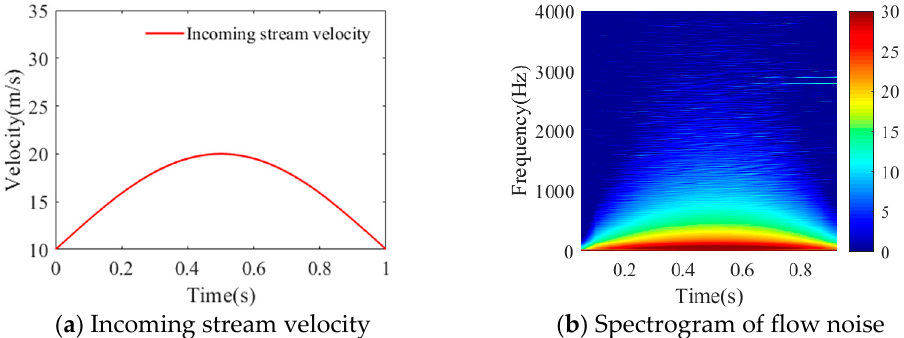
Figure 11. Inconstant incoming stream velocity and the corresponding spectrogram of flow noise.